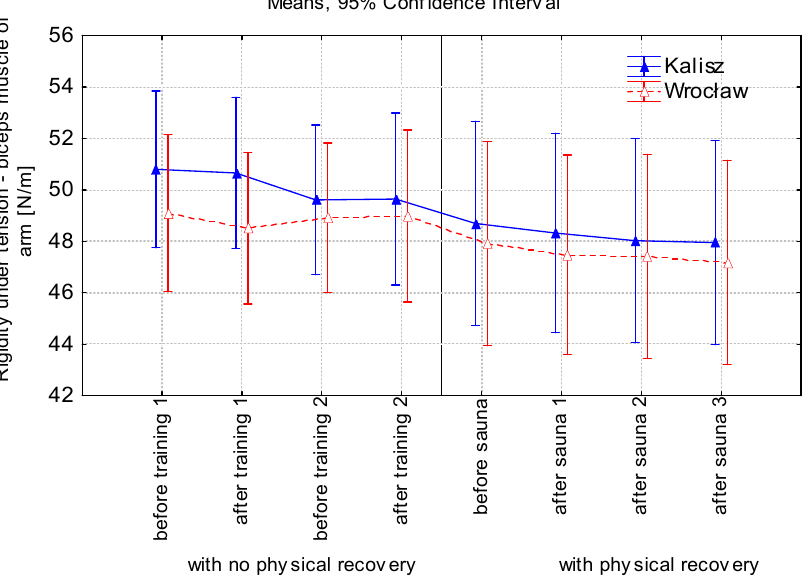
Figure 4. Stiffness in the deltoid muscle under tension for disabled swimmers in the training cycle without and with athletic